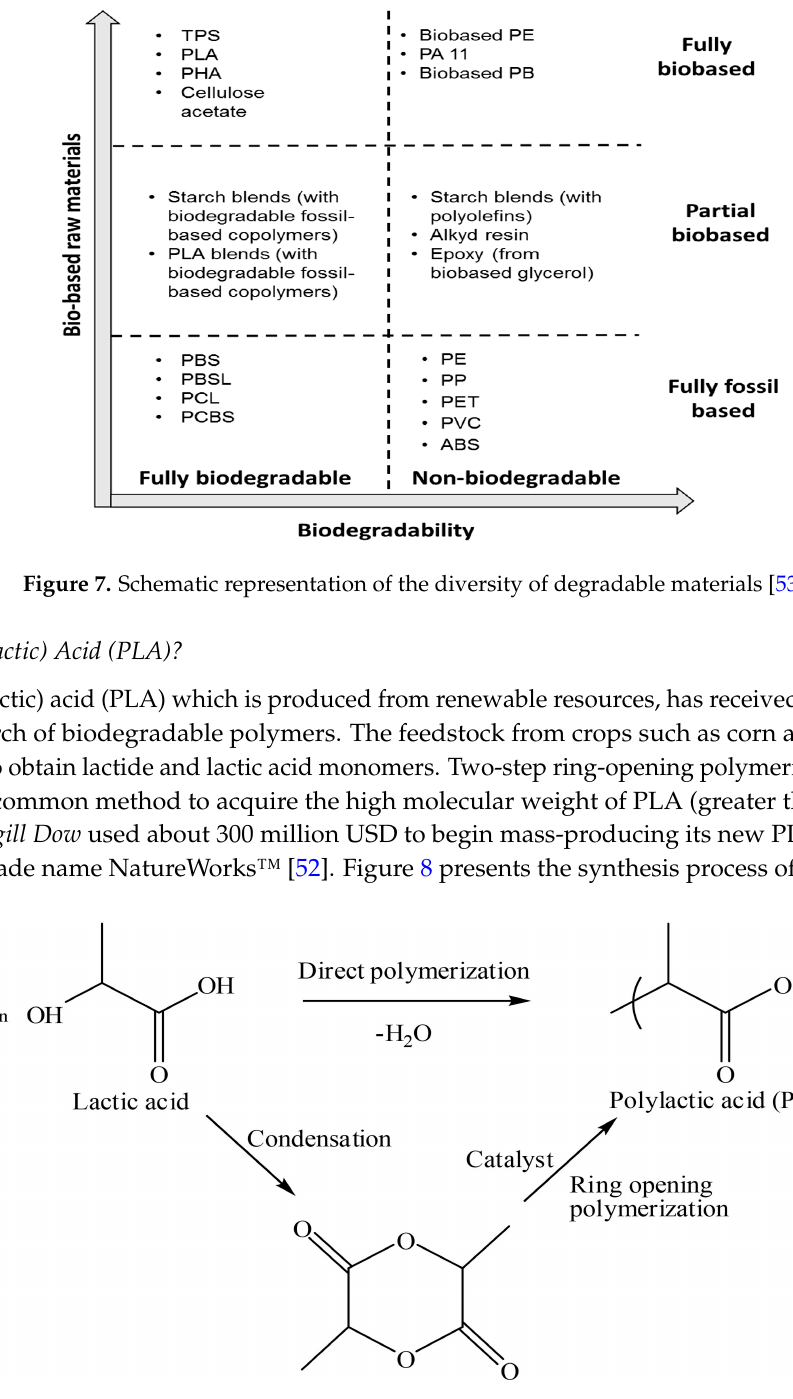
Figure 8. Synthesis of poly (lactic) acid (PLA) [54].